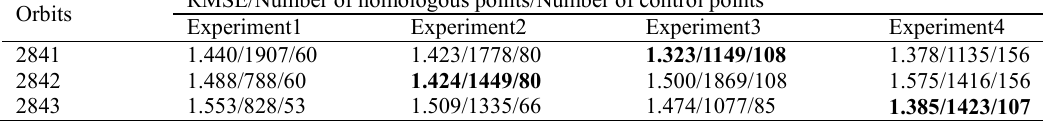
Table 3.The RMSE of check points’ offset on three orbit IIM images after registration